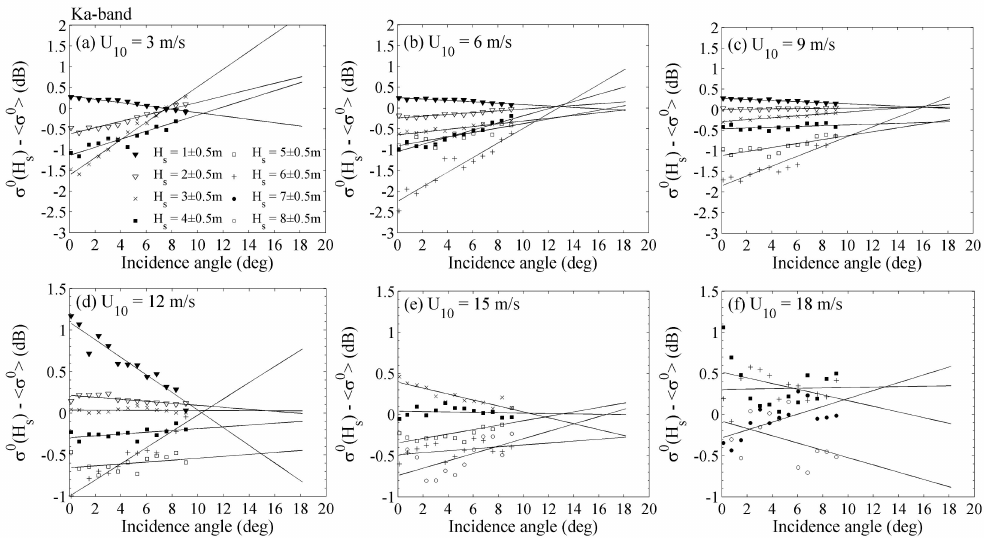
Figure 11. Magnitude of the difference between KaPR σ 0 averaged over various 1-m significant wave height ( H s ) classes and the values averaged over all H s as functions of incidence angle at selected wind speeds: ( a ) 3m/s, ( b ) 6m/s, ( c ) 9m/s ( d ) 12m/s ( e ) 15m/s (f ) 18m/s. Overlaid are linear regression fits to better display the